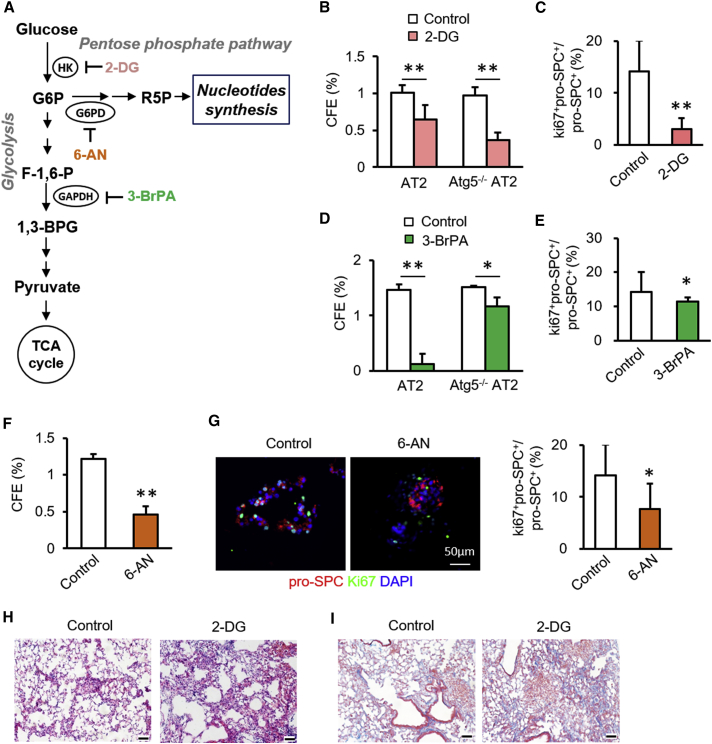
AT2 Cell Proliferation Requires Glucose Metabolism(A) Schematic of intermediates and their inhibitors associated with glycolytic and pentose phosphate pathways.(B) CFE of mouse AT2 and Atg5−/− AT2 cells with or without 2-DG (n = 5).(C) Proportions of Ki67+pro-SPC+ cells in total pro-SPC+ cells in the presence and absence of 2-DG (n = 5).(D) CFE of AT2 and Atg5−/− AT2 cultures with and without 3-BrPA (n = 5).(E) Proportions of Ki67+pro-SPC+ cells in total pro-SPC+ cells in organoid cultures in the presence and absence of 3-BrPA (n = 5).(F) CFE of mouse AT2 cells cultures with or without 6-AN (n = 5).(G) Immunostaining of organoid cultures and quantification of Ki67+pro-SPC+ cells in total pro-SPC+ cells in the presence and absence of 6-AN (n = 5).(H and I) After intratracheal instillation of BLM, Atg5f/f mice were intraperitoneally injected with PBS or 100 mg/kg 2-DG. At 14 days after BLM, lungs were harvested for hematoxylin/eosin (H) and Masson trichrome (I) staining. Scale bar: 50 μm. Data are representative of two independent experiments with error bars representing the mean ± SD. ∗p < 0.05, ∗∗p < 0.01.